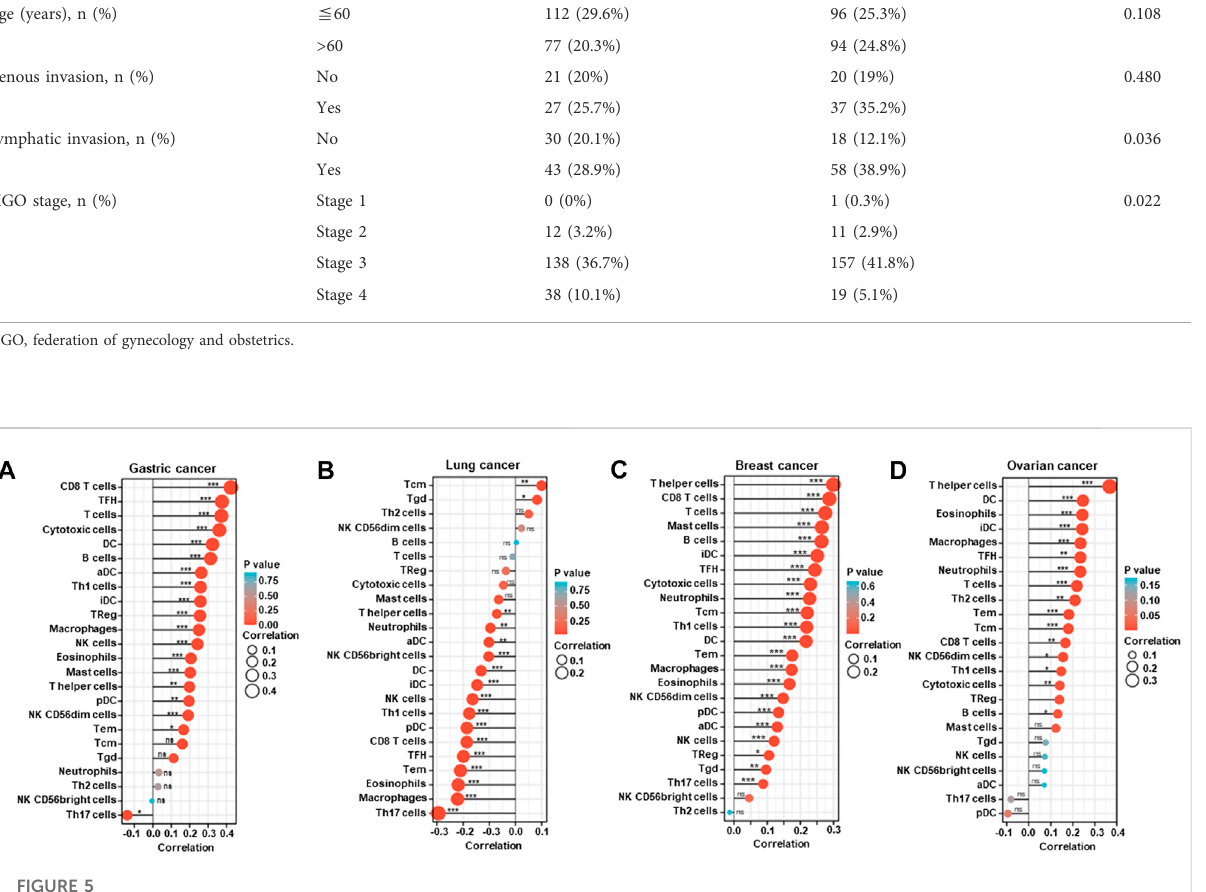
TABLE 4 The correlation of BTG1 mRNA expression with clinicopathological features of ovarian cancer. Characteristic